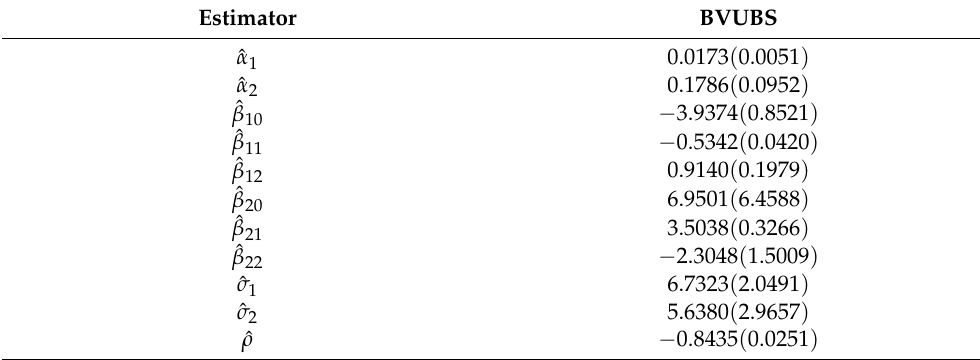
Table 2. Estimation of the parameters with their standard errors for the BVUSHN regression